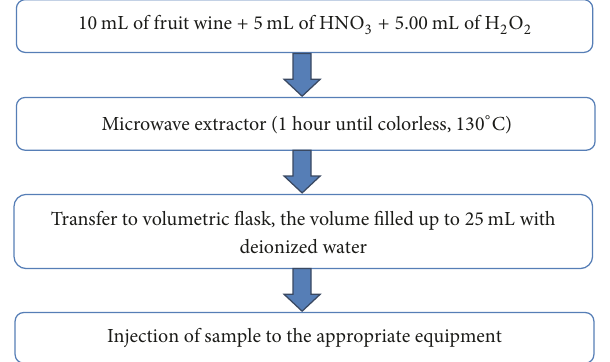
Figure 1: Procedure of sample preparation for spectroscopic analy-